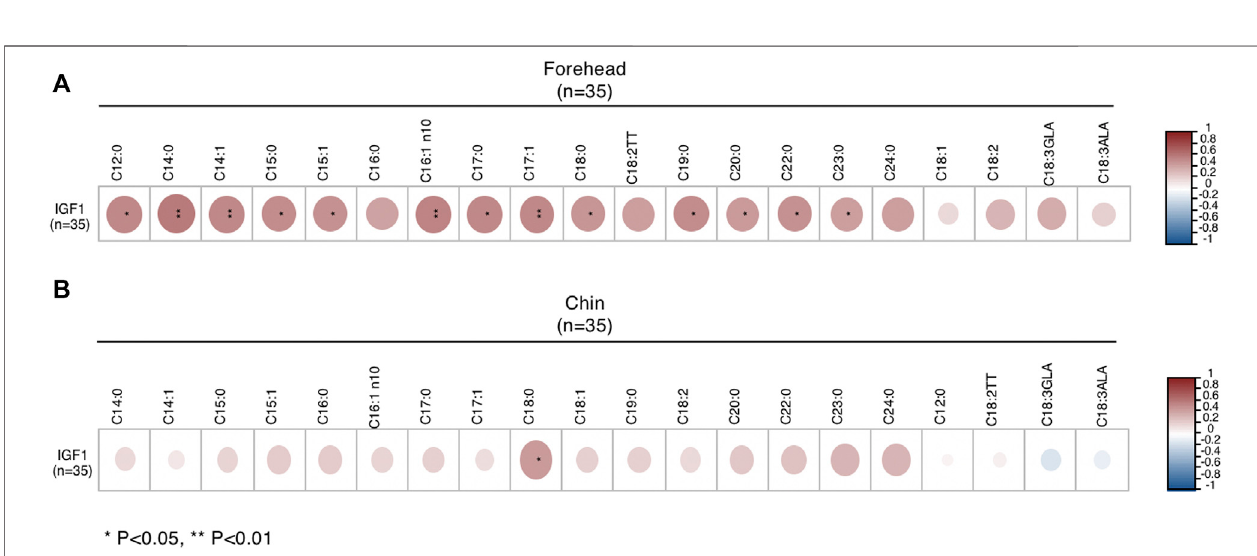
FIGURE 4 | Correlations between IGF1 levels and FA of sebum from forehead (A) and chin (B) in male subjects. *p < 0.05 and **p < 0.01.